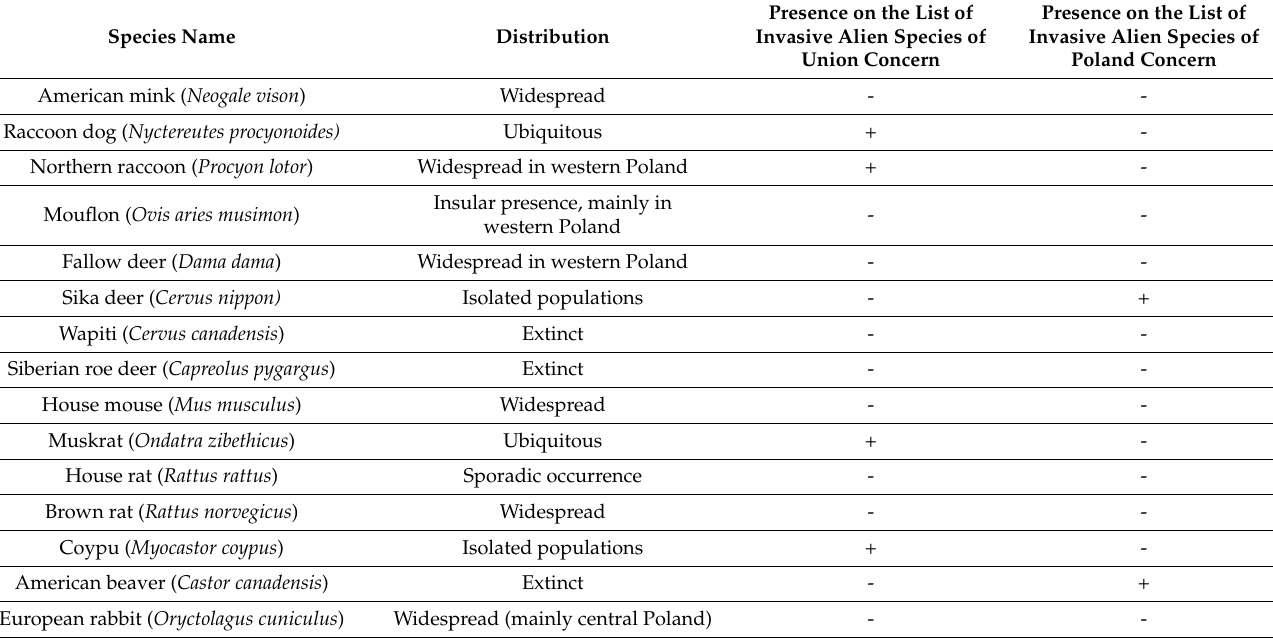
Table 1. Non-native mammals that have been recorded under natural conditions in Poland, along with their current distribution and presence (+) or lack (-) on the List of Invasive Alien Species of Union concern and the List of Invasive Alien Species of Poland concern. Common names are according to the IUCN Red List and ITIS